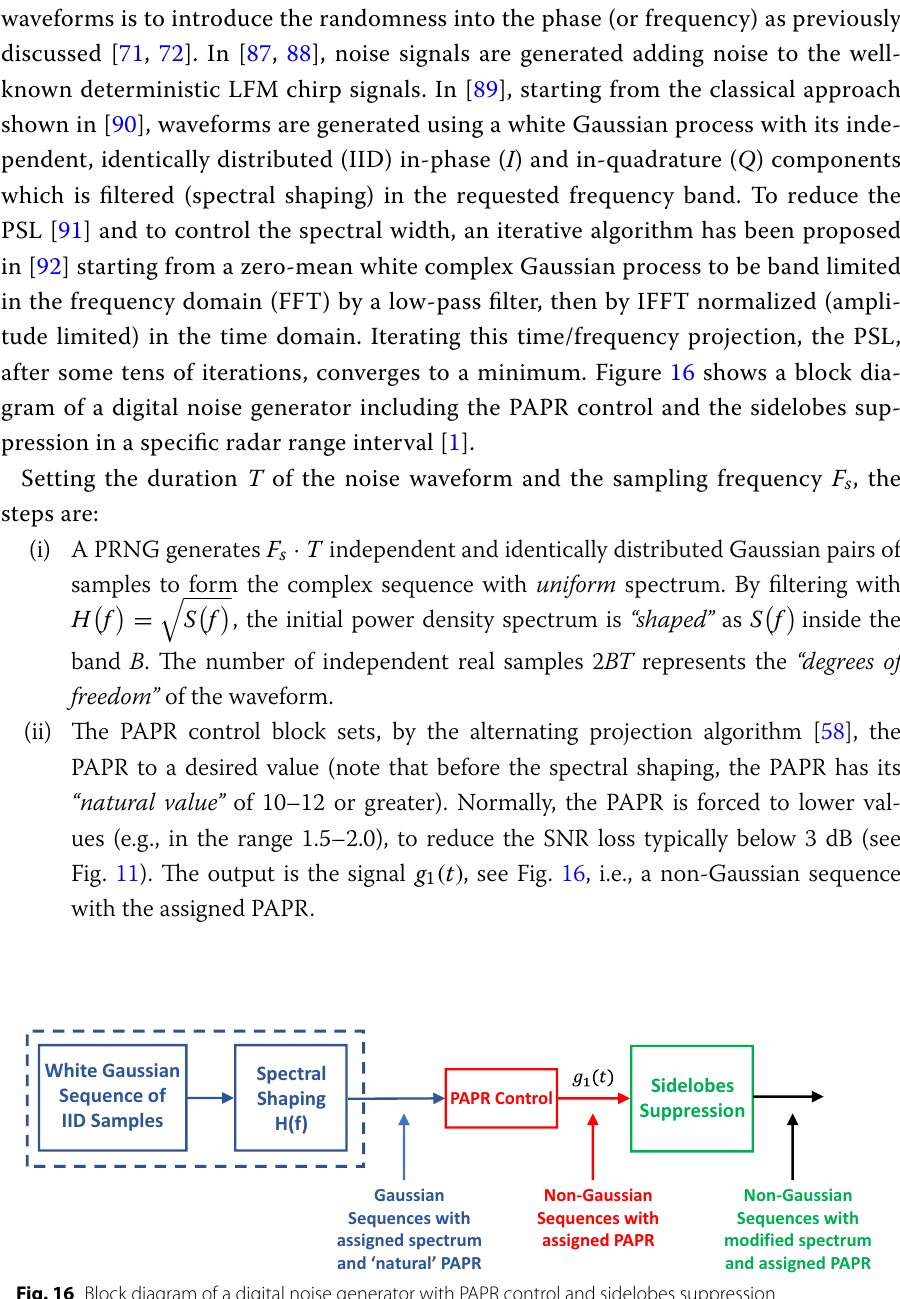
Fig. 16 Block diagram of a digital noise generator with PAPR control and sidelobes